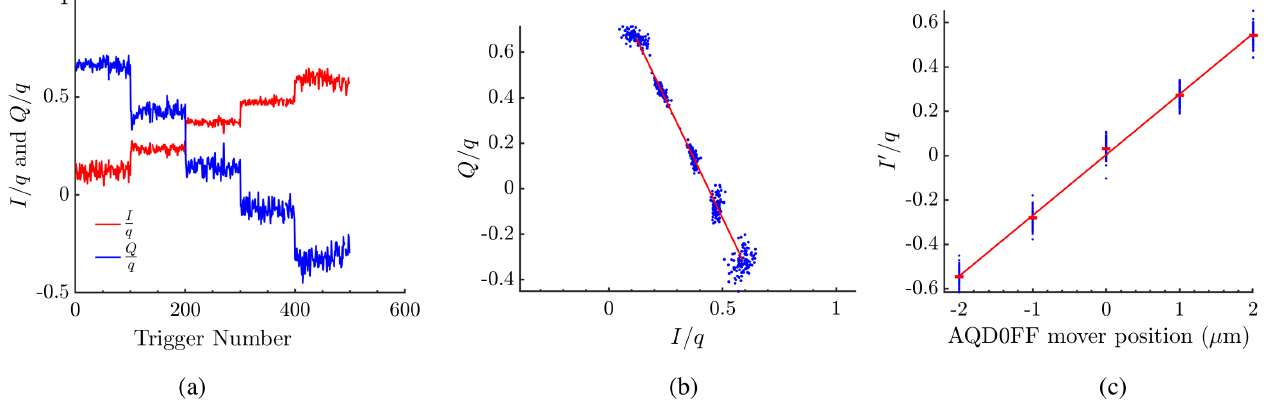
FIG. 10. Example vertical position calibration of IPA, using an 11-sample integration range: (a) I (b) Q versus I (points); the line shows a least-squares fit to determine θ IQ ¼ − 1 . 093 (cid:1) 0 . 006 radians; (c) the data points show I 0 q q QD0FF mover position, the red error bars show the standard error on the mean values at each QD0FF setting and the red line shows a least-squares fit, which yields k ¼ 0 . 184 (cid:1) 0 . 002 μ m − 1 .